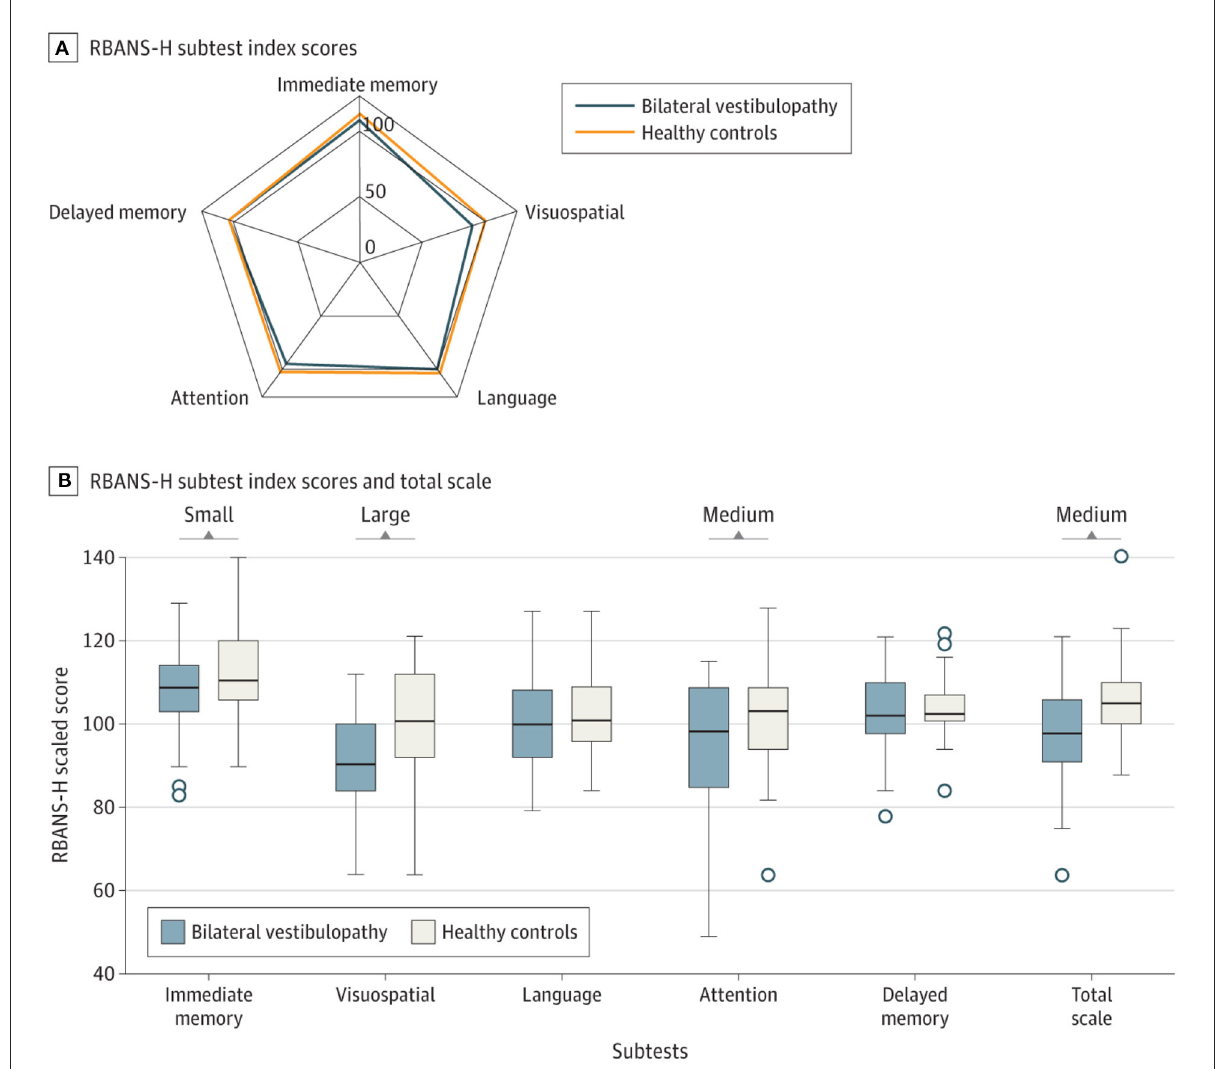
FIGURE1 Effects of bilateral vestibulopathy on the Repeatable Battery for the Assessment of Neuropsychological Status (RBANS-H) scores in different cognitive domains. Comparison of RBANS-H scores between individuals with bilateral vestibulopathy and their matched healthy controls. (A) The relationship between the scores for immediate memory, delayed memory, attention, language and visuospatial function for bilateral vestibulopathy patients and healthy controls. (B) Whiskers indicate range; boxes, interquartile range (IQR); circles indicate outliers; bold line, median d . Small (Cohen’s d = 0.2), medium (Cohen’s d = 0.5), and large (Cohen’s = 0.8) indicate clinically meaningful Cohen’s d effect sizes. While there were medium and large differences for attention and visuospatial memory, there were only small effects for immediate